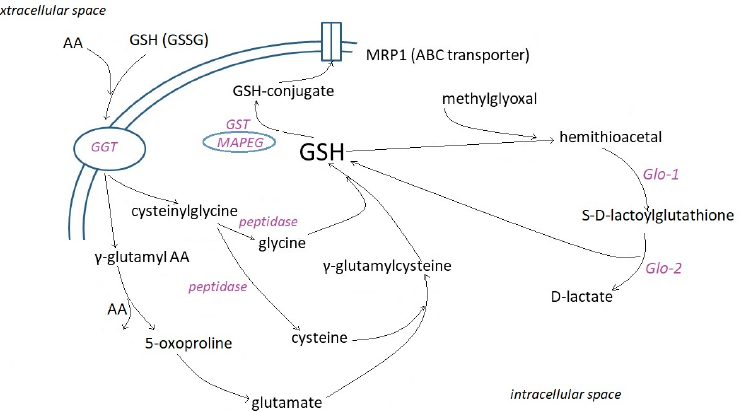
Figure 2. Involvement of γ -glutamyl transpeptidase (GGT), glutathione-S-transferases (GST), their subfamily of Membrane Associated Proteins in Eicosanoid and Glutathione metabolism (MAPEG), and glyoxylases (Glo) in the intracellular metabolism of GSH. MRP1 (multidrug resistance-associated protein 1) transporter facilitates the unidirectional transport of conjugates.